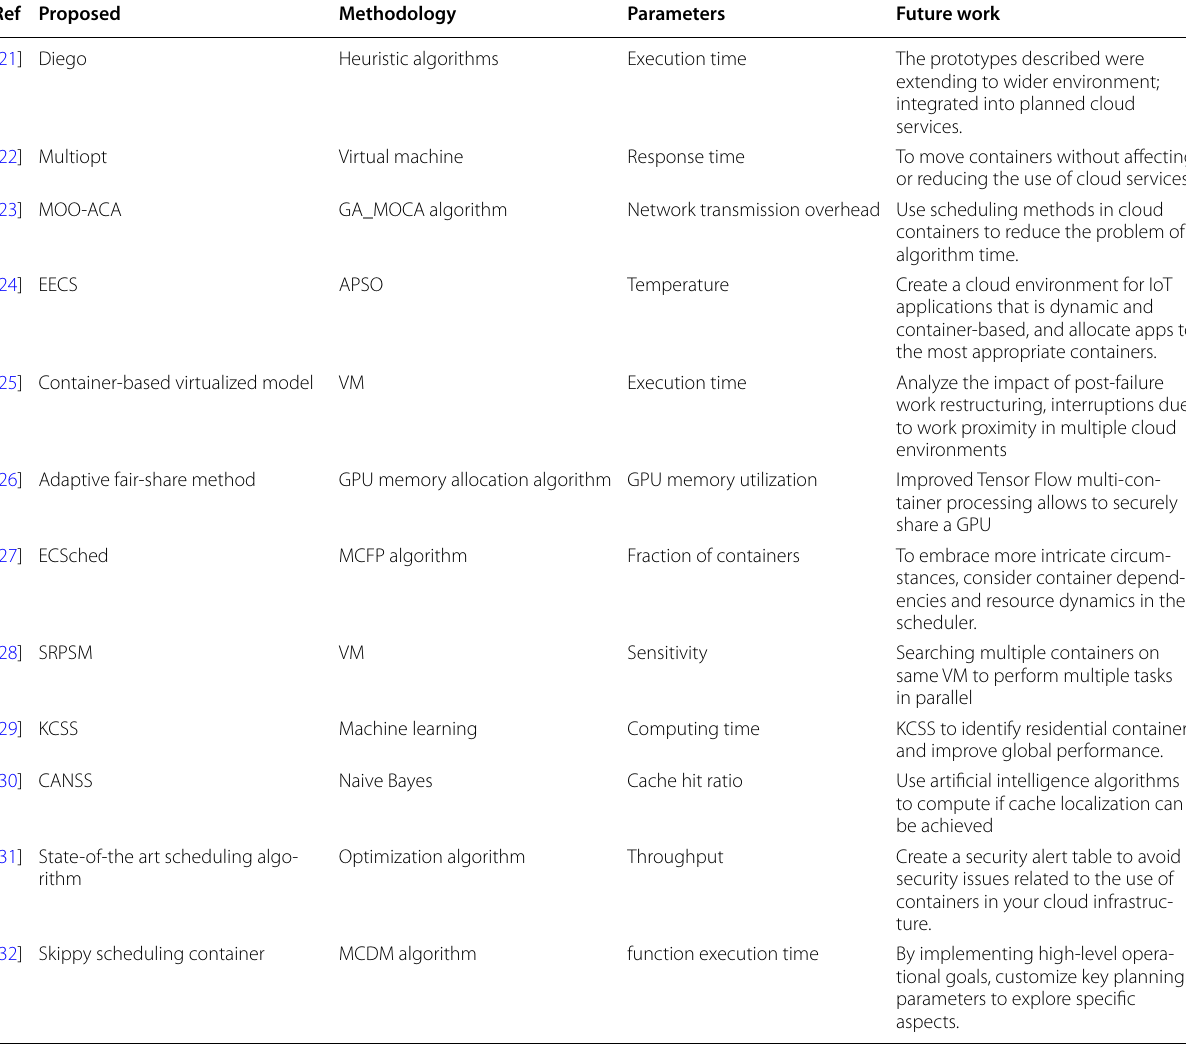
Table 1 Summary of research gaps Ref